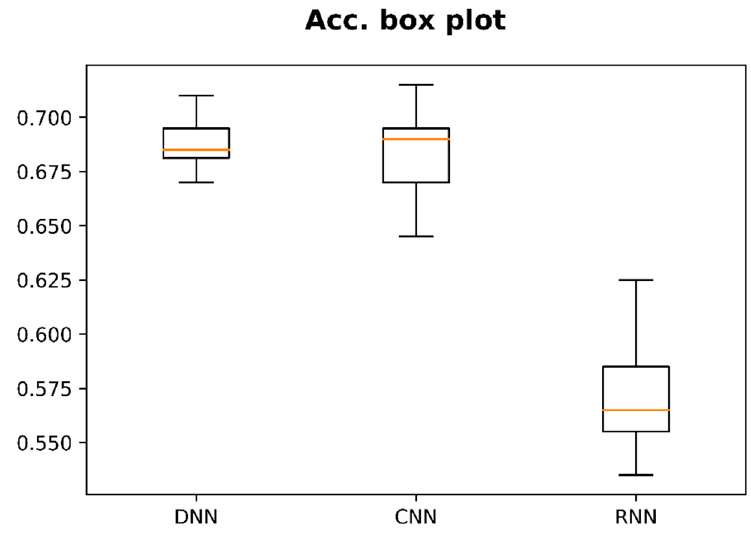
Figure 10. Accuracy boxplot for the 30 test results for each deep learning model.